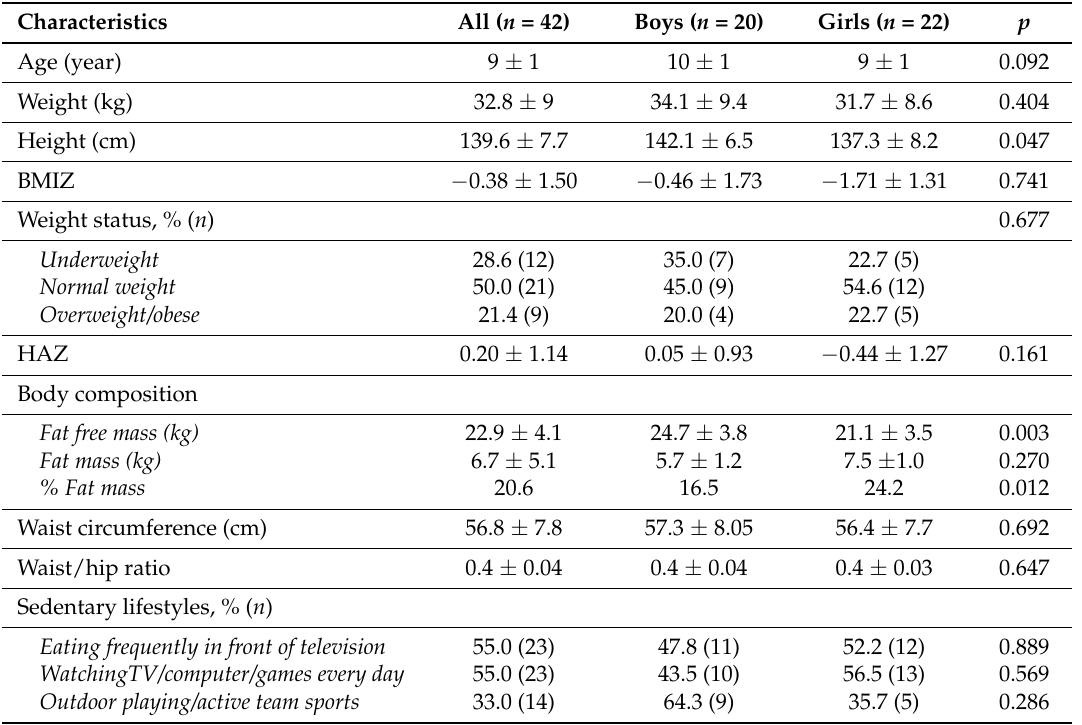
Table 1. Characteristics of the school-aged